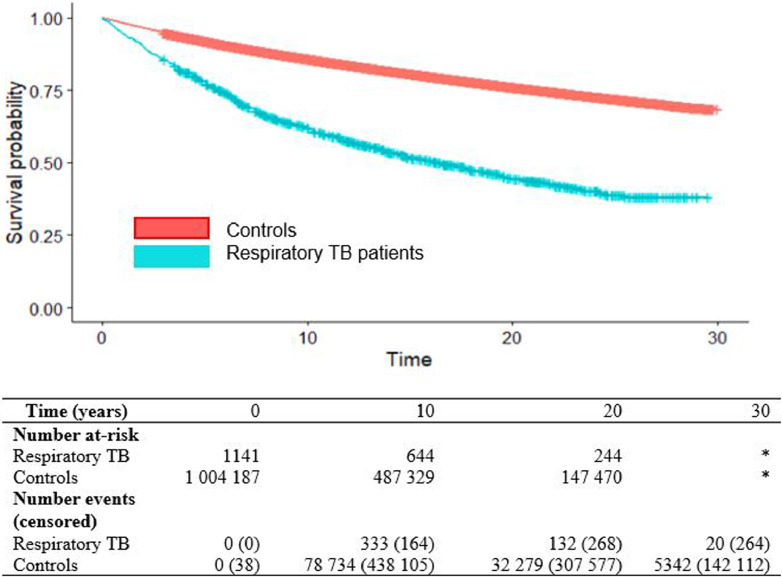
Kaplan–Meier plot for airway disease-free time (years) among people immigrating to British Columbia, Canada 1985–2015: respiratory tuberculosis patients vs non-tuberculosis controls. Legend: teal = respiratory TB; red = non-TB controls. Notes: Asterisk (*) indicates suppressed due to cell count <6, or cross-suppressed as next lowest value.